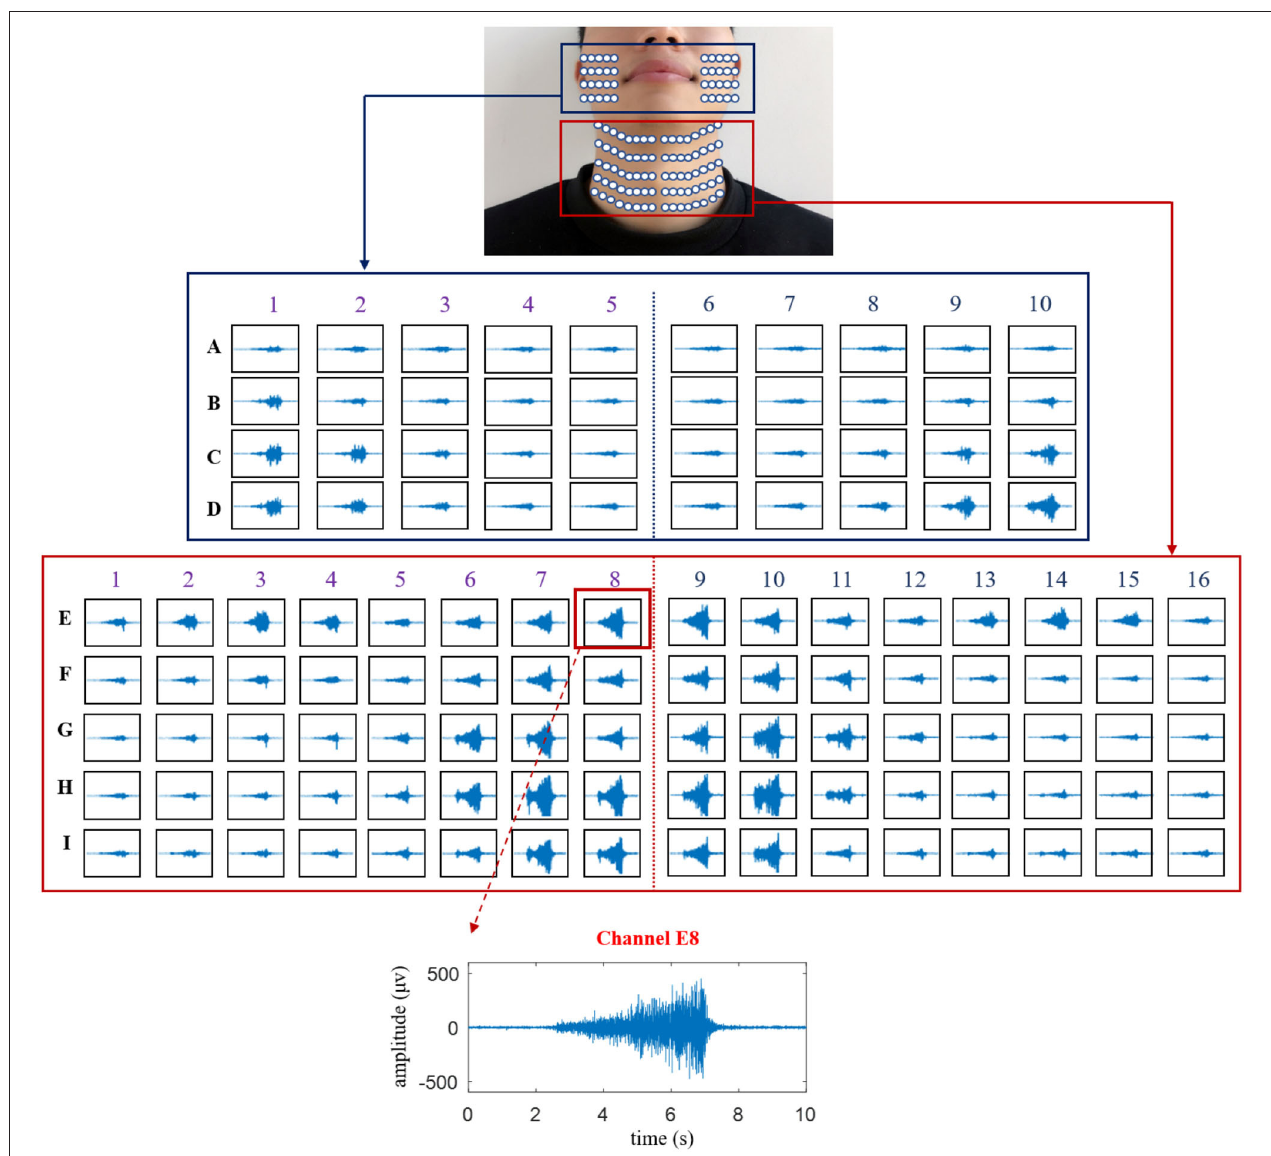
FIGURE 4 | The temporal waveforms of the HD sEMG signals recorded from all the 120 surface electrodes on the facial and neck muscles during the phonation with rising pitch.